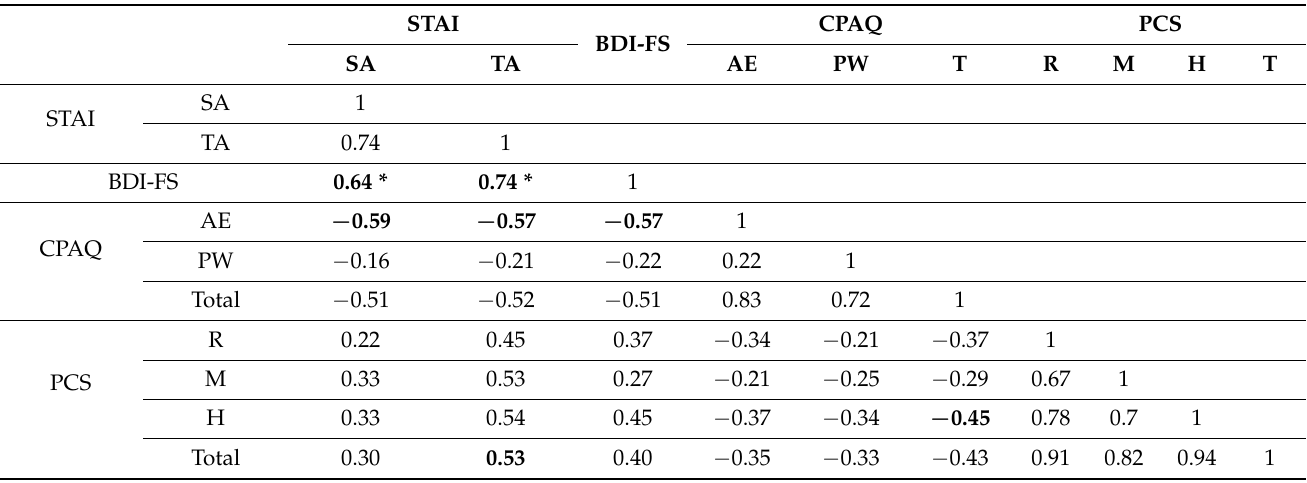
Table 5. Pearson correlations between clinical